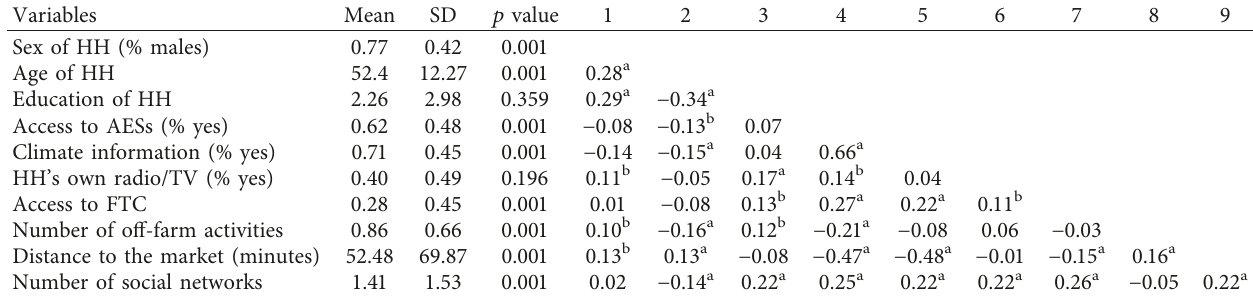
Table 1: Means, standard deviations, and pairwise correlations among variables ( n � 358).